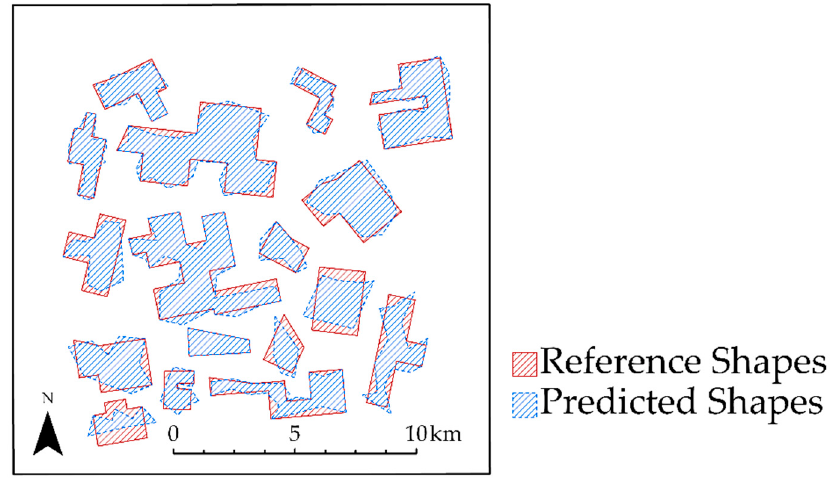
Figure 6. Synthetic shapes used in the third example.